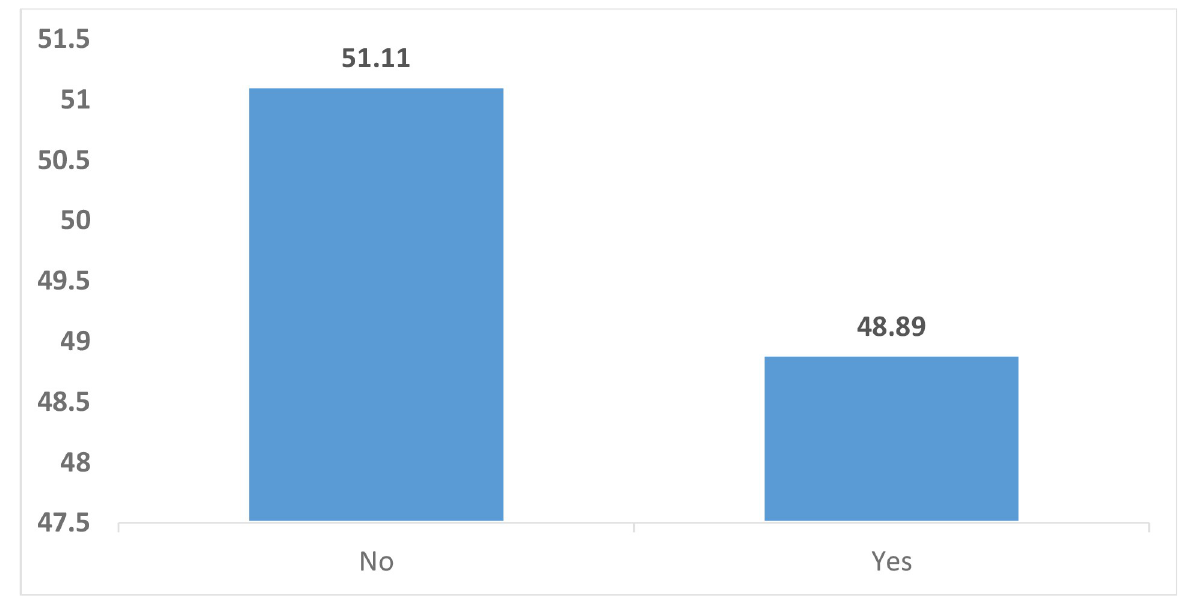
Fig 2. Prevalence of healthcare seeking for childhood illnesses in